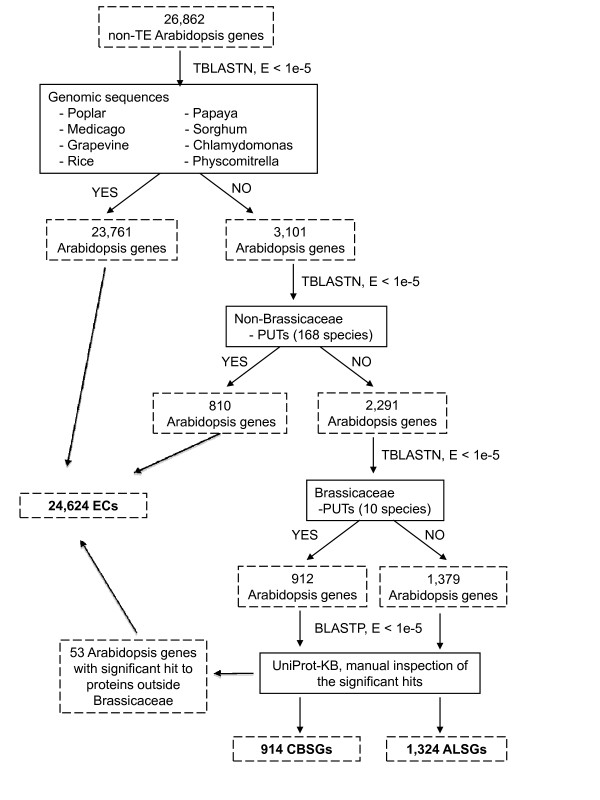
Identification of lineage specific genes in A. thaliana. The solid boxes reflect non-Arabidopsis sequences used in the searches while the hashed boxes show the Arabidopsis genes.